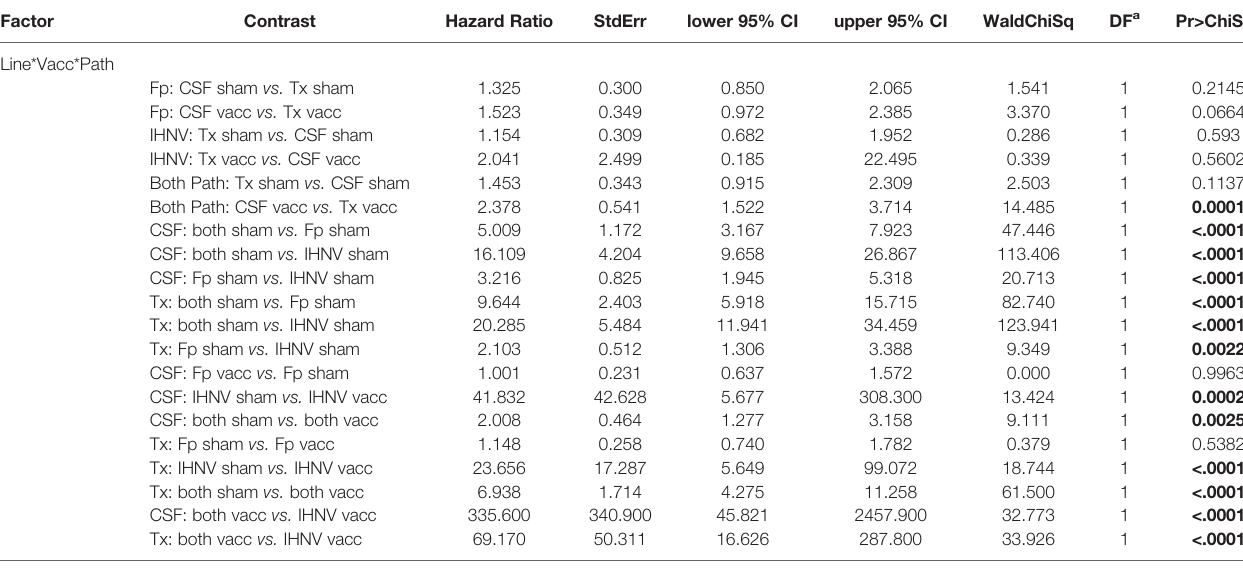
TABLE 6 | Model contrasts, hazard ratio and P-value for comparisons from laboratory experiment. Factor Contrast Hazard Ratio StdErr lower 95% CI upper 95% CI WaldChiSq DF a Pr>ChiSq b Line*Vacc*Path Fp: CSF sham vs. Tx